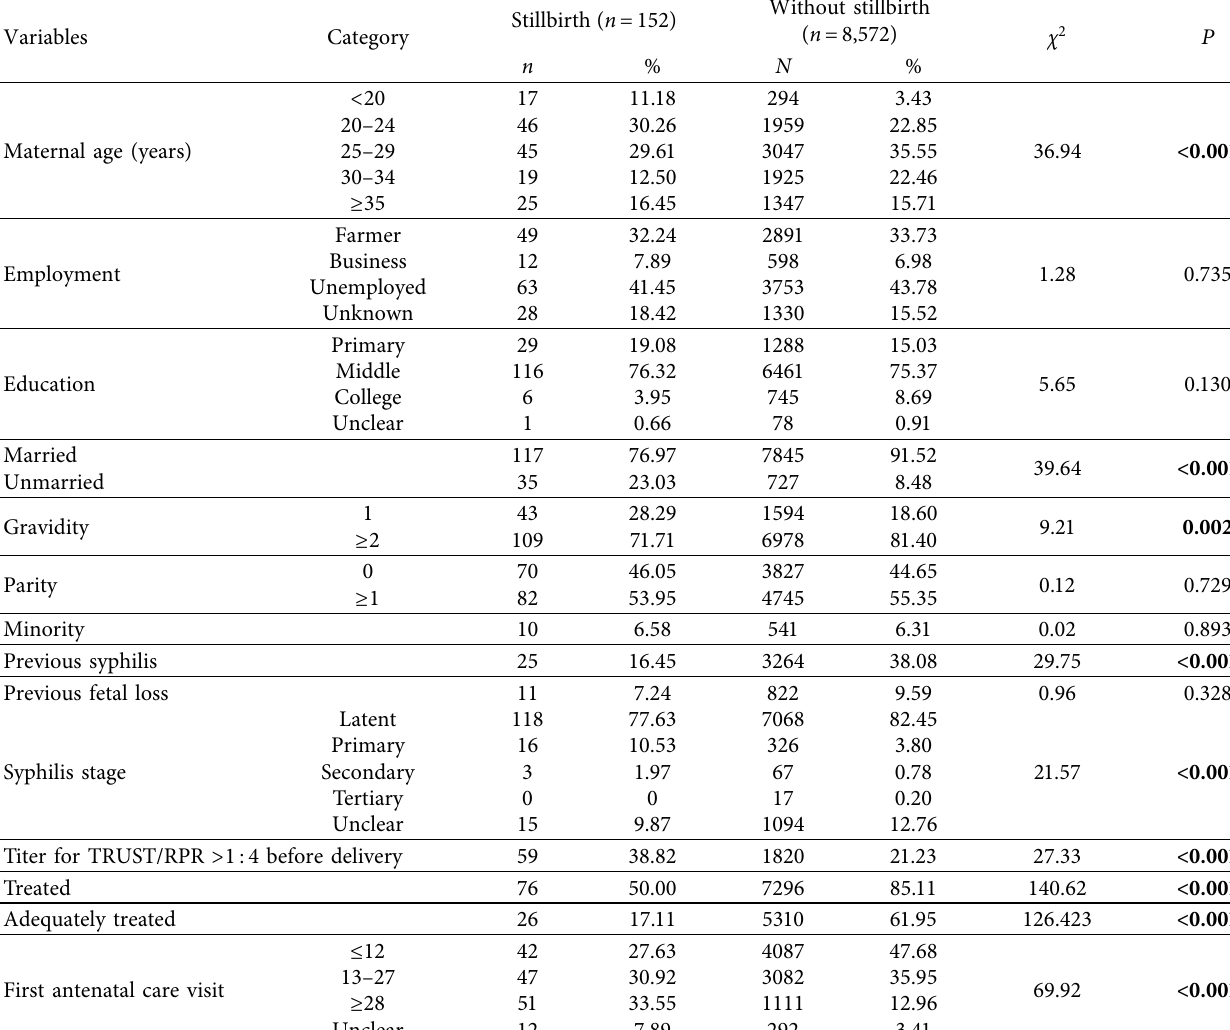
Table 1: Comparison of maternal sociodemographic characteristics and syphilis condition between women who had stillbirths and women who had live births.